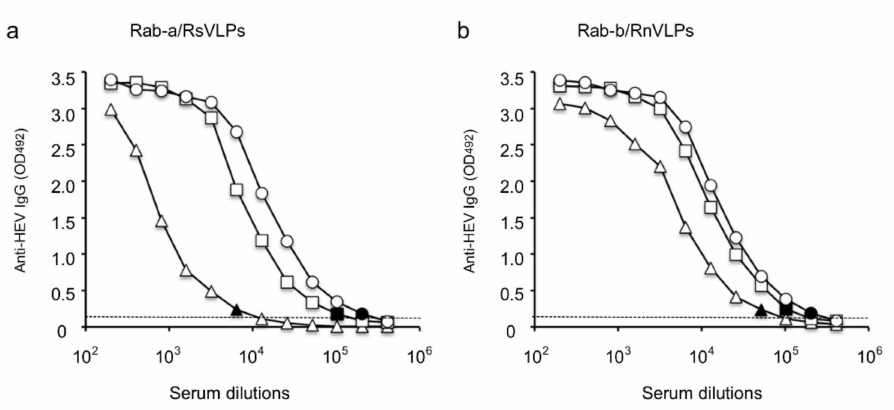
ELISA ( a ). Similarly, the reactivity of anti-HEV-3 IgG ( b ), that of anti-HEV-4 IgG ( c ) and that of anti-rat HEV IgG ( d ) was